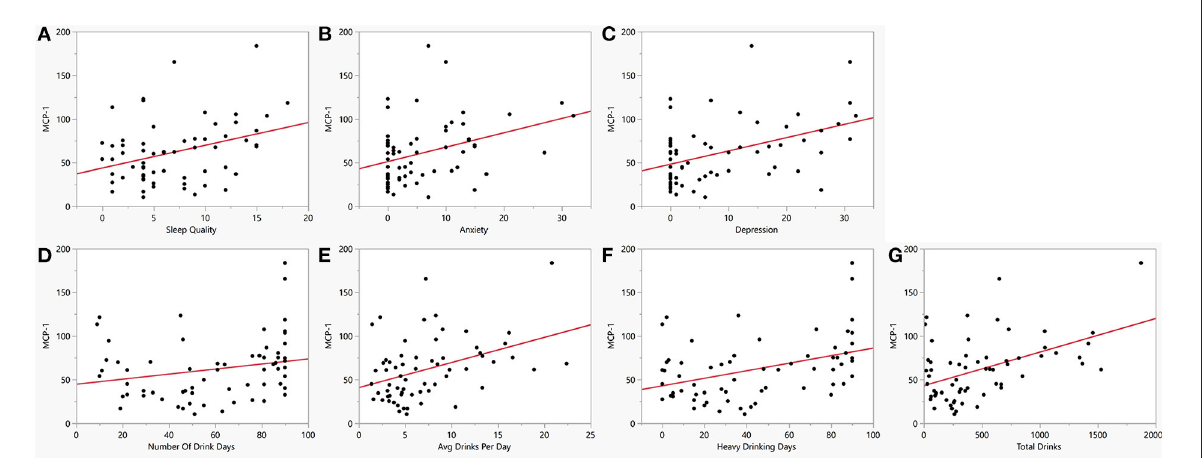
FIGURE4 Bivariate plot of cytokine MCP1 and co-occurring symptoms in AUD. MCP-1 (y-axis) vs. (A) Sleep measured by PSQI (x-axis, R = 0.40, p = 0.004), (B) Anxiety measured by BSA ( x -axis, R = 0.39, p = 0.006), (C) Depression measured by MADRS (x-axis, R = 0.44, p = 0.002), (D) Number of drinking days (x-axis, R = 0.42, p = 0.002), (E) Average drinks per day (x-axis, R = 0.51, p < 0.001), (F) Heavy drinking days (x-axis, R = 0.54, p < 0.001), and (G) Total number of drinks (x-axis, R = 0.61, p < 0.001). Red line represents regression